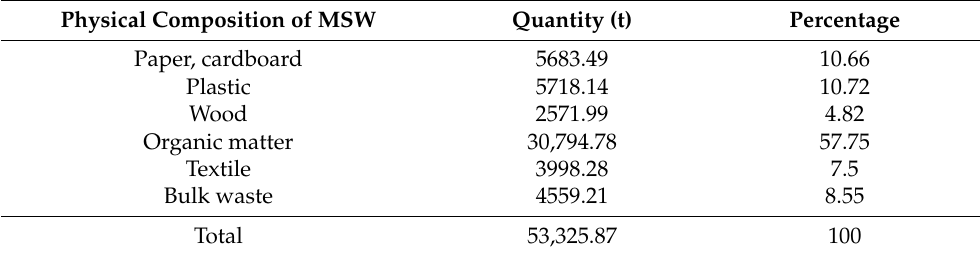
Table 1. Estimated annual amount of municipal solid waste (MSW) for incineration. Physical Composition of